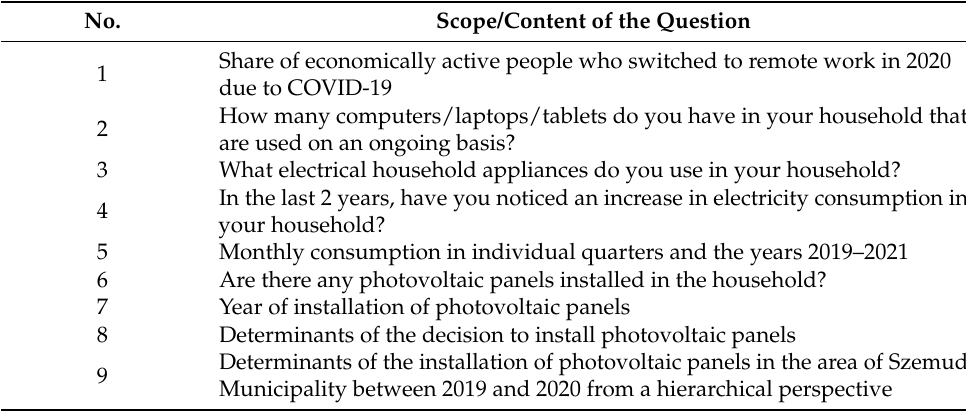
Table 1. List of questions used in the